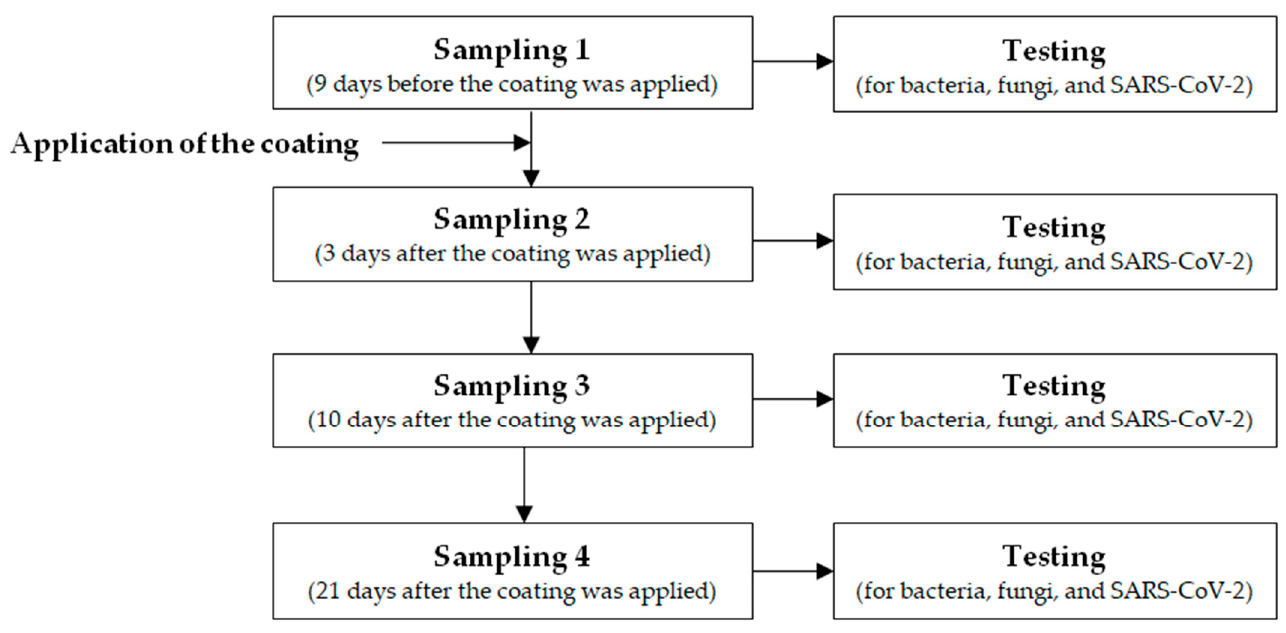
Figure 1. Flow of environmental investigation